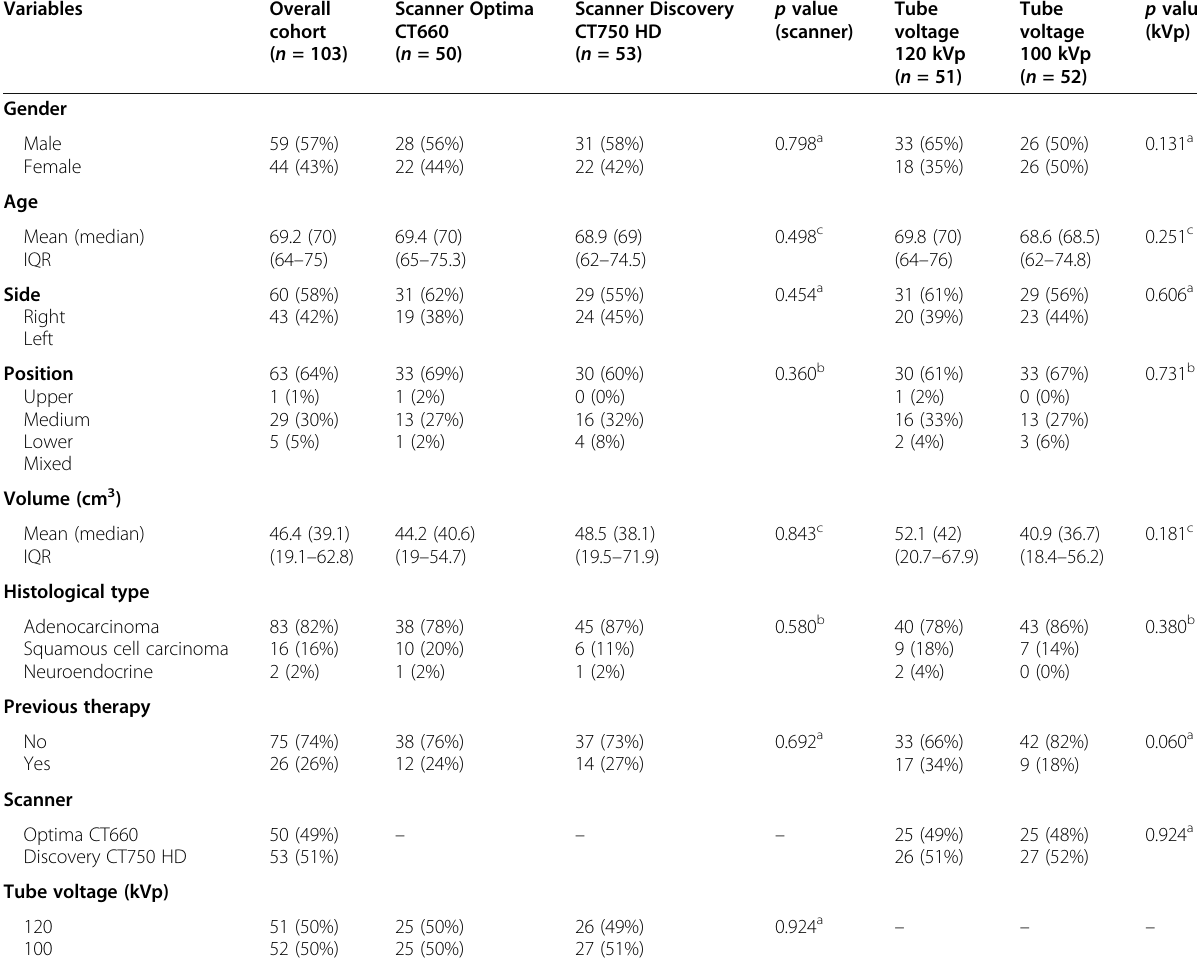
Table 1 Baseline characteristics of the study population.